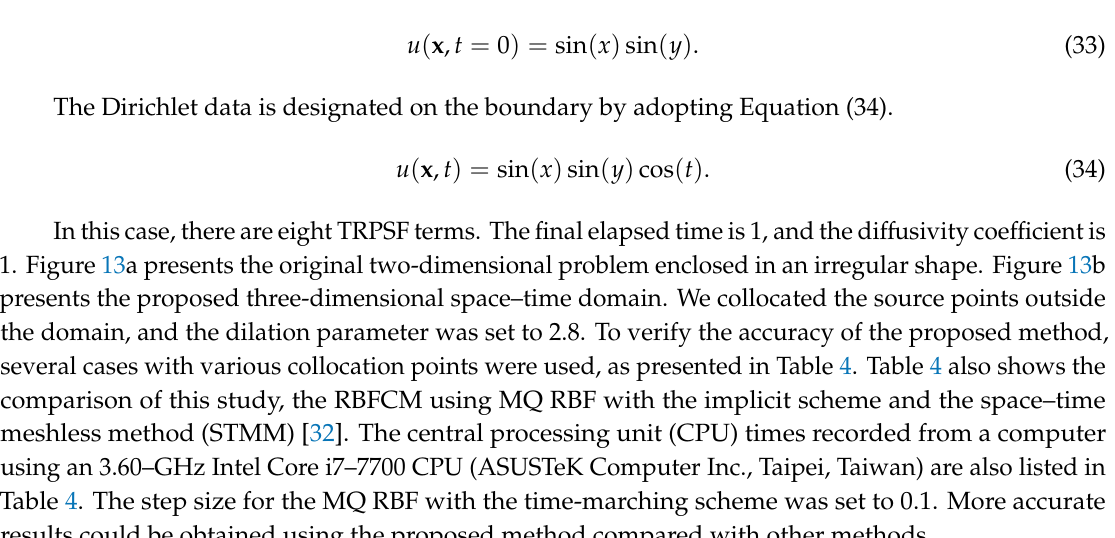
Table 4. The step size for the MQ RBF with the time-marching scheme was set to 0.1. More accurate results could be obtained using the proposed method compared with other